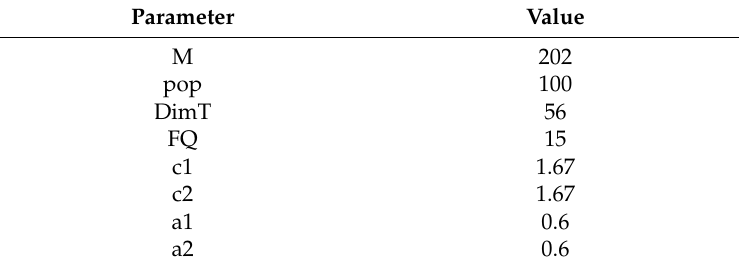
Table 7. Parameters of the best experiment with trapezoidal membership